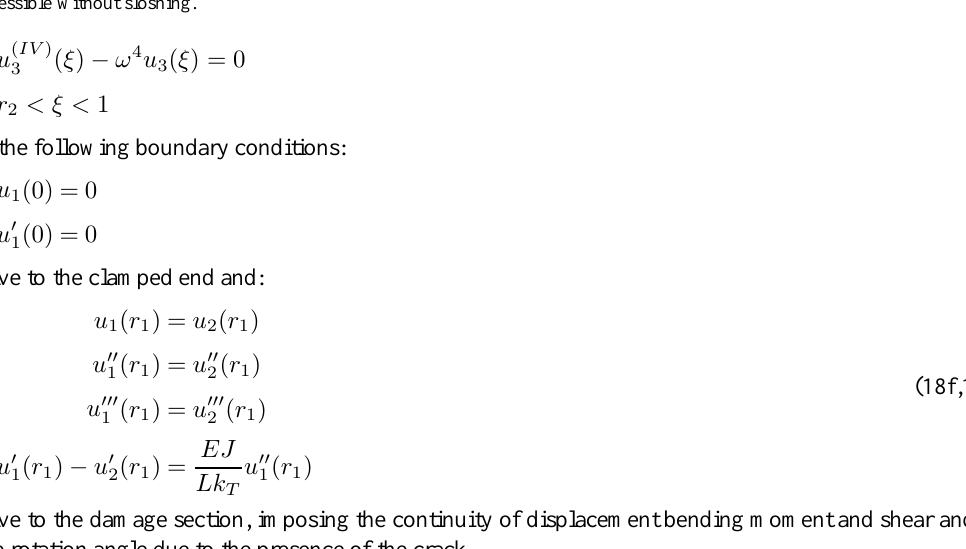
Fig. 5. The second structural frequency parameter of the coupled system as a function of the position of the crack. The fluid is considered to be compressible without